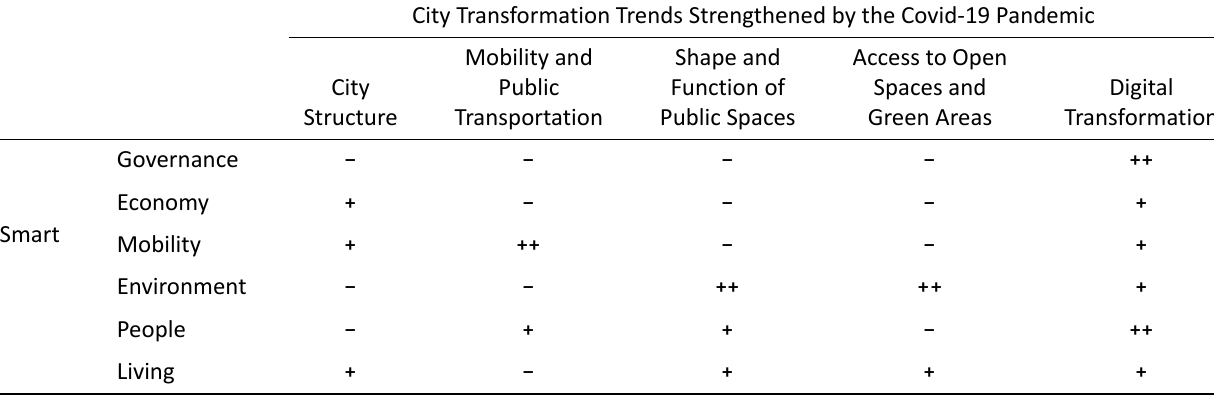
Table 1. Impact of the pandemic‐caused changes on the development of various aspects of smart cities. City Transformation Trends Strengthened by the Covid‐19